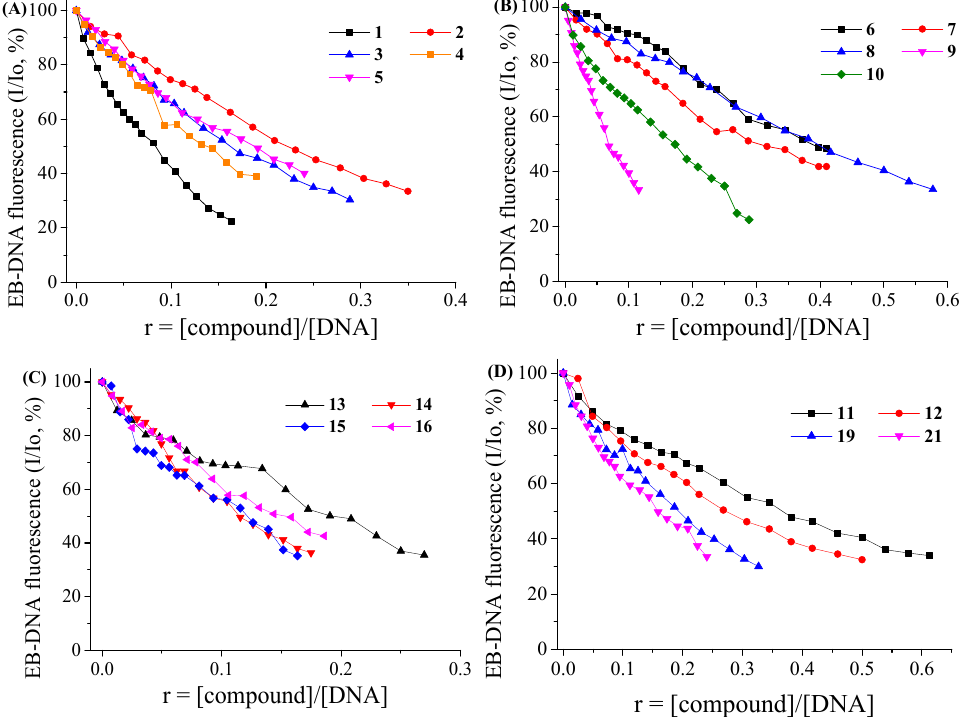
Figure 9. Plot of EB-DNA relative fluorescence emission intensity (%I/Io) at λ em = 592 nm vs. r ( r = [compound]/[DNA]) in buffer solution (150 mM NaCl and 15 mM trisodium citrate at pH 7.0) in the presence of compounds ( A ) 1 – 5 (quenching up to 22.6% of the initial EB-DNA fluorescence for 1 , 33.5 for 2 , 30.4% for 3 , 39.8% for 4 and 40.1% for 5 ); ( B ) 6 – 10 (quenching up to 48.6% of the initial EB-DNA fluorescence for 6 , 41.9% for 7 , 33.6% for 8 , 33.4% for 9 and 22.6% for 10 ); ( C ) 13 – 16 (quenching up to 35.5% of the initial EB-DNA fluorescence for 13 , 36.3% for 14 , 35.2% for 15 and 42.6% for 16 ); ( D ) 11 , 12 , 19 and 21 (quenching up to 33.9% of the initial EB-DNA fluorescence for 11 , 32.5% for 12 , 30.0% for 19 and 33.6% for 21